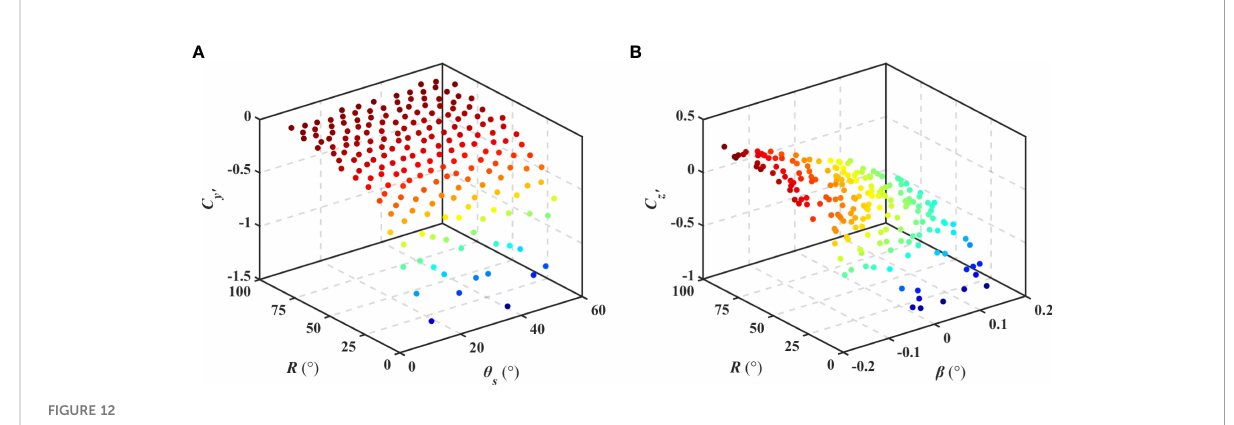
FIGURE 12 Hydrodynamic coef fi cients obtained in rotating arm pool numerical